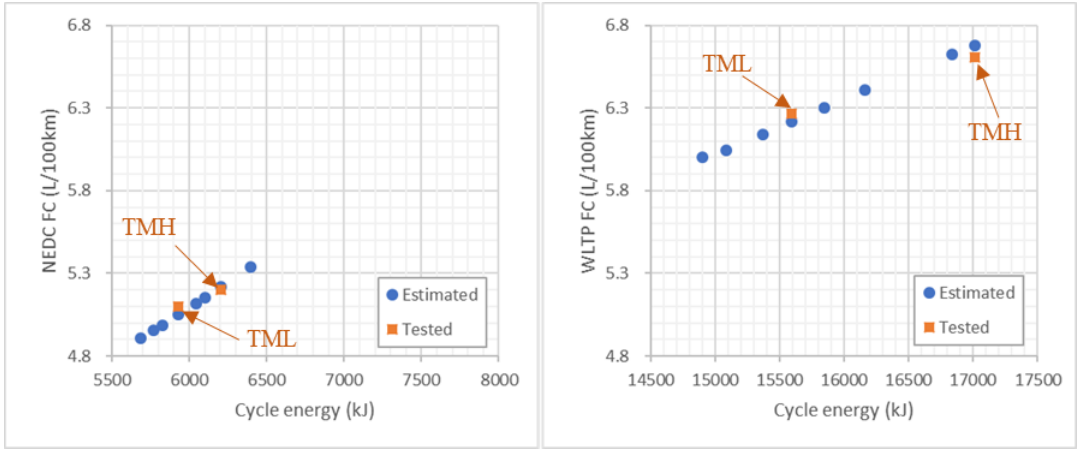
Figure 9. Fuel consumption under NEDC and WLTP according to the cycle energy of the 1.6-L diesel engine .